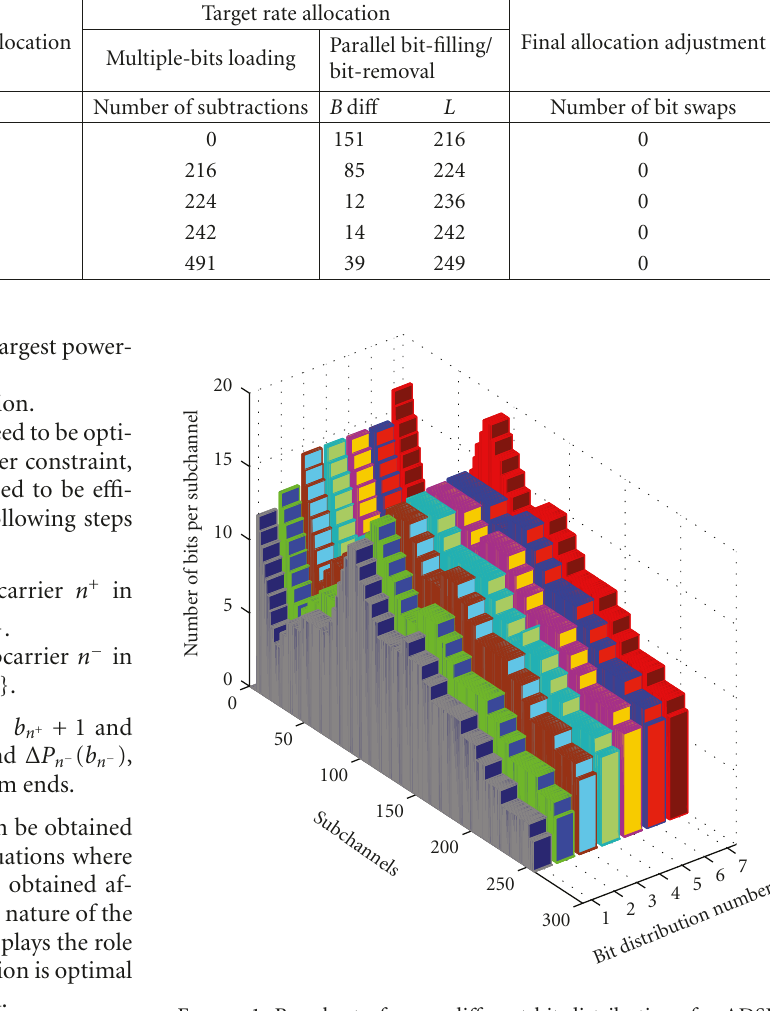
Figure 1: Bar chart of seven di ff erent bit distributions for ADSL loop